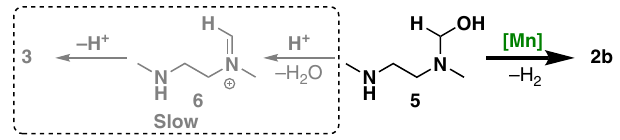
Fig. 5 Analysis of the competitive reaction pathways of intermediate 5 .